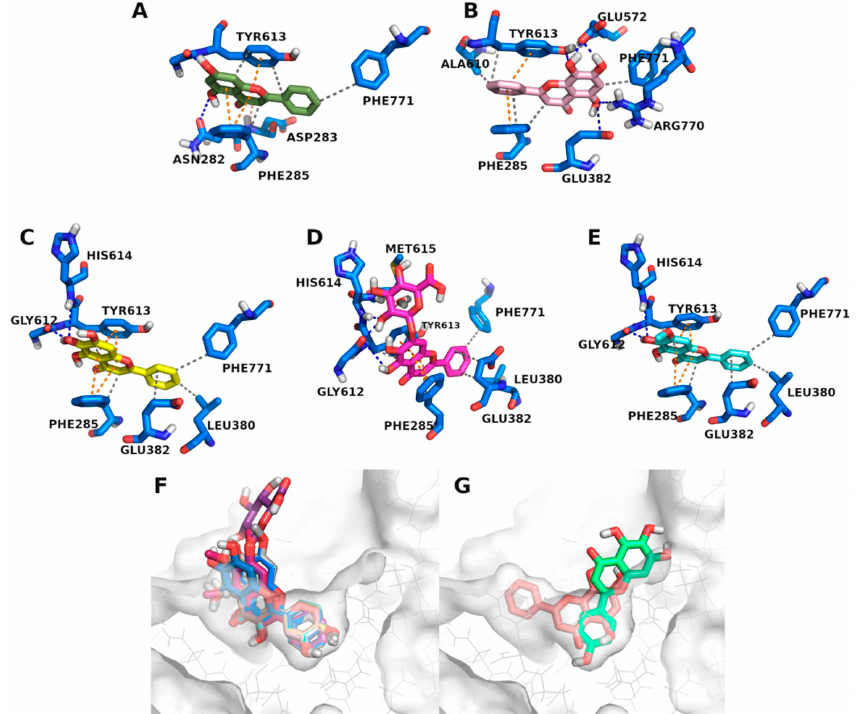
Figure 6. Placement of flavonoids in the GPa inhibitor binding site. ( A ) Contacts established by compound 38 (dark green). ( B ) Contacts established by compound 46 (light pink). ( C ) Contacts established by compound 47 (yellow). ( D ) Contacts established by compound 49 (magenta). ( E ) Contacts established by compound 51 (pale blue). ( F ) All flavonoids, except 46 and 48 , inside the GPa inhibitor binding site, versus ( G ) 46 (light pink) and 48 (turquoise). Bond types are encoded as follows: hydrophobic interactions (grey), hydrogen bonds (blue), pi-stacking (orange).